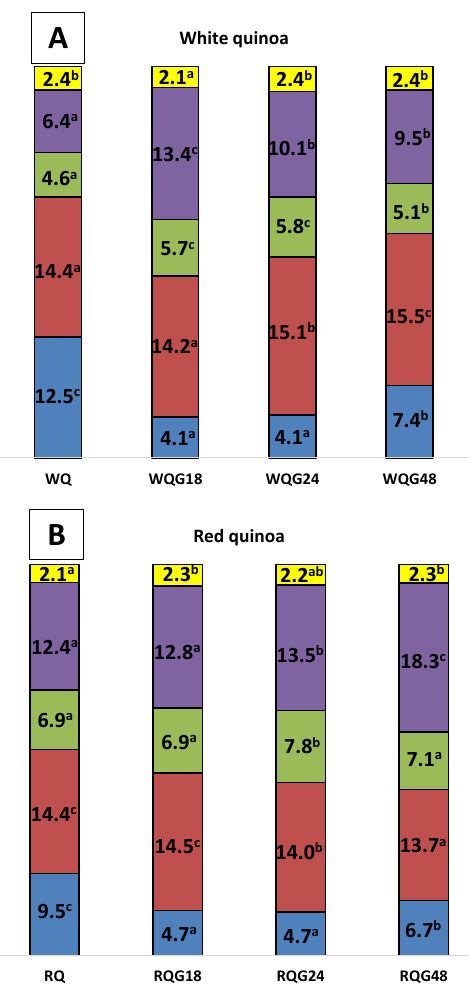
Figure 1. Proximal composition of flours. Percentage of moisture (blue), proteins (red), lipids (green), total dietary fiber (violet) and ashes (yellow). ( A ) White quinoa flour without germination (WQ) and germinated 18 h (WQG18), 24 h (WQG24) and 48 h (WQG48). ( B ) Ungerminated red quinoa flour (RQ) and germinated 18 h (RQG18), 24 h (RQG24) and 48 h (RQG48). Different letters indicate significant differences in the same variety of quinoa ( p <